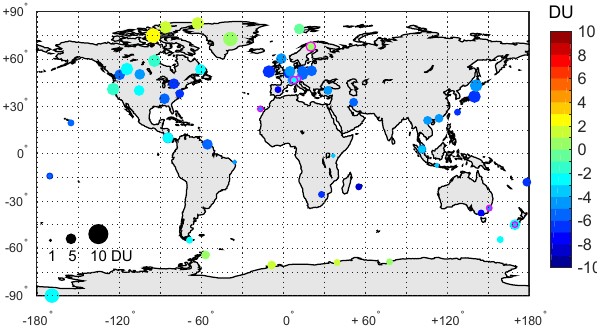
Figure 2. Spatial distribution of ozonesonde and FTIR stations used in this study. The different colors represent the mean biases in Dob- son units (DU) between IASI-A and sonde TROPO O 3 columns (defined as the surface–300hPa column) at each station and the dot size represents the standard deviation. The average is performed for the period from January 2008 to July 2017. The mean bias between the IASI-A and FTIR TROPO O 3 columns is indicated by the dots circled in